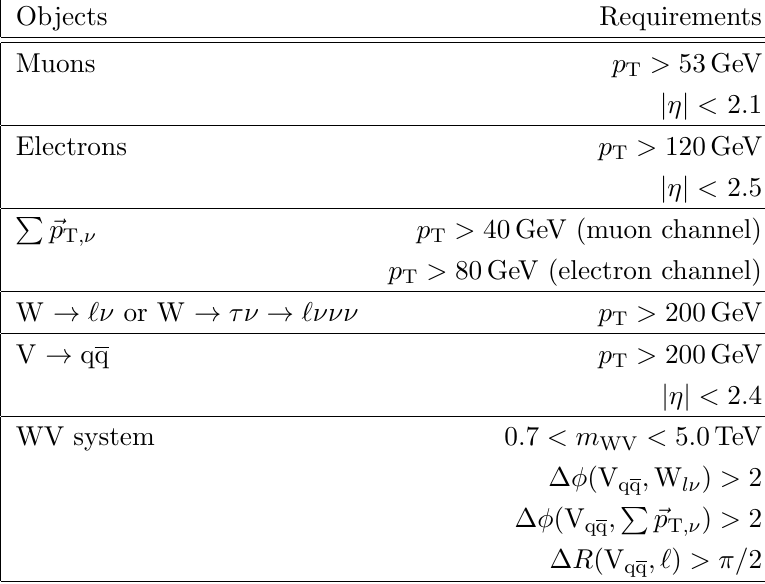
Table 9 . Generator-level requirements for the ‘(cid:23) +jet analysis, to be used for the computation of the e(cid:14)ciency parametrization. The vector sum of the transverse neutrino momenta P ~p T ;(cid:23) is taken over all the neutrinos in the (cid:12)nal state, coming either from W ! ‘(cid:23) or W ! (cid:28)(cid:23) ! ‘(cid:23)(cid:23)(cid:23) decays with ‘ = (cid:22) or e.